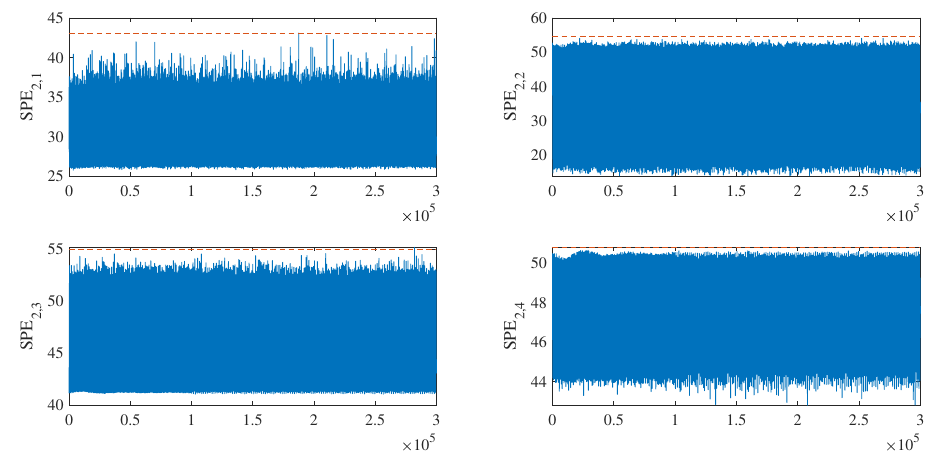
Figure 13. Deep PCA-based fault detection for f 1 (raw data).